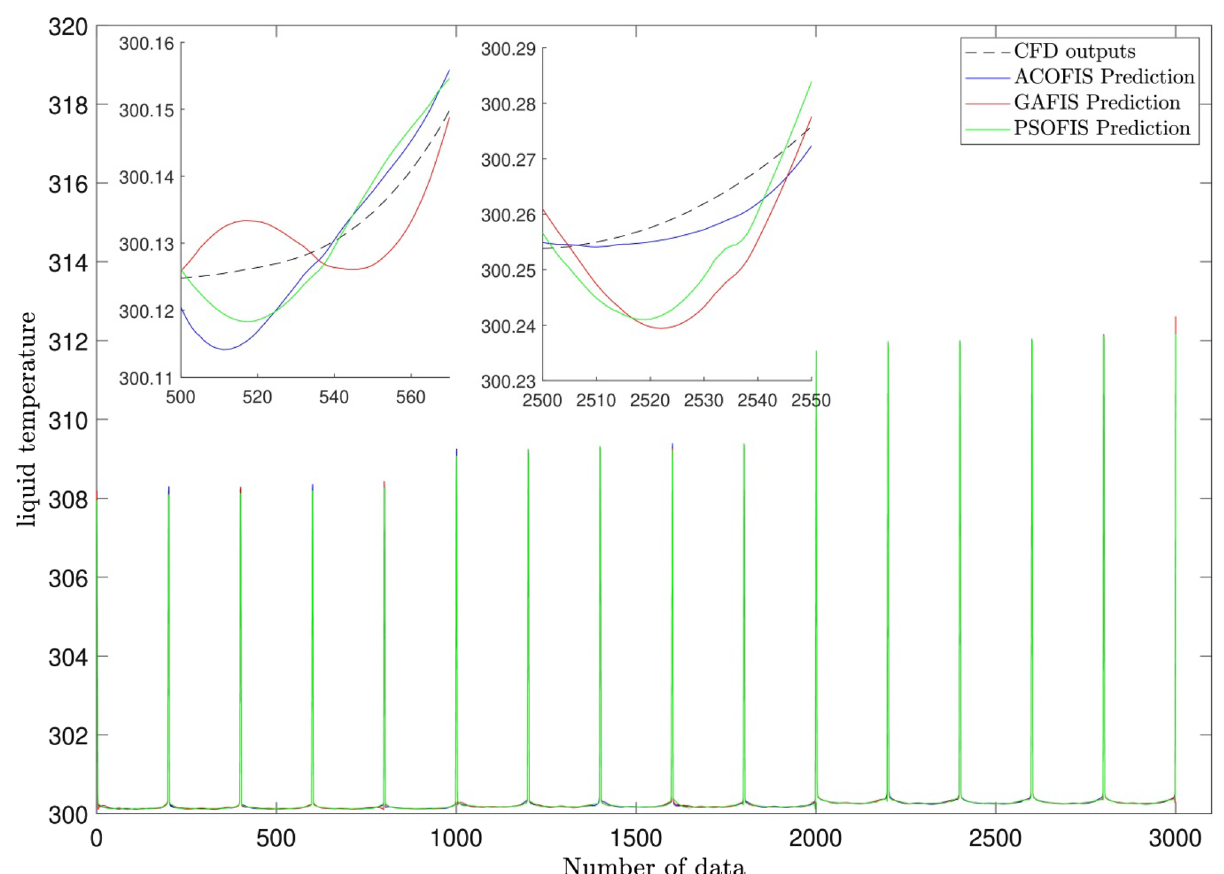
Figure 11. Prediction of liquid temperature in the bubble column reactor by ACOFIS, GAFIS, PSOFIS